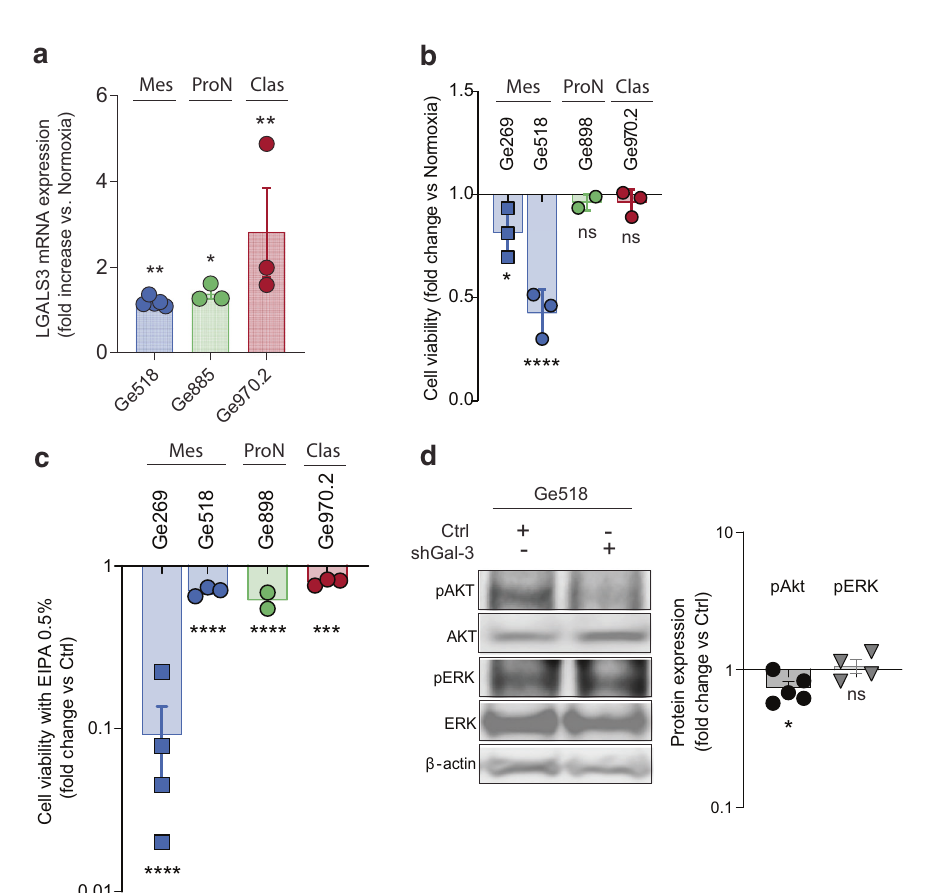
Fig. 3 Gal-3 expression is modulated by hypoxia and activates Akt. a Effect of hypoxia (1%) during 48 h on Gal-3 expression determined by qPCR in GSCs and normalized to housekeeping genes (HKGs) ( n = 3 – 5). b Effect of hypoxia (1%) on cell viability during 72 h, measured by CellTiter-Glo. c Effect of EIPA on cell viability under hypoxic conditions during 72 h, measured by using CellTiter-Glo ( n = 2 – 4). d Immunoblots showing expression of indicated proteins when Gal-3 is knocked down in Ge518. Histograms represent the fold change of protein expression determined by densitometry analysis ( n = 4). Data are represented as mean ± SEM (* p < 0.05, ** p < 0.01, and *** p < 0.001), two-way ANOVA, Sidak ’ s adjusted p value. ns nonsigni fi cant,